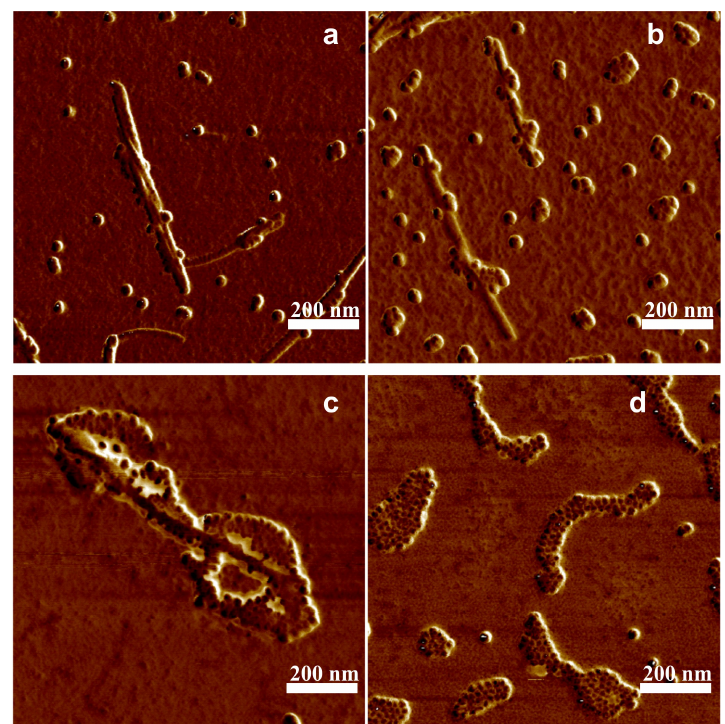
Figure 5. AFM phase image of lysozyme fibrils doped with magnetic nanoparticles with diameter of 10 nm. The volume of ( a ) 10 µ L, ( b ) 15 µ L, ( c ) 20 µ L, ( d ) 30 µ L of MNPs solution was added to 300 µ L of